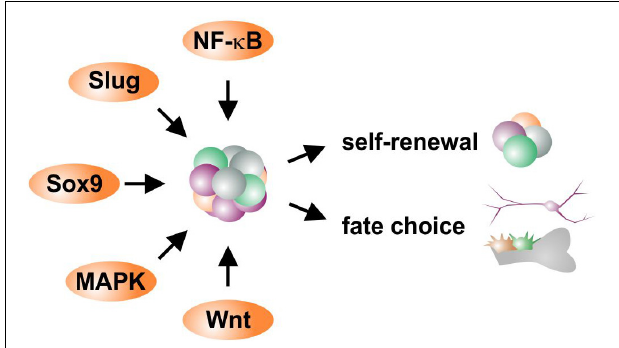
FIGURE 5 | Schematic view of potential molecular regulators defining self-renewal and fate choices of